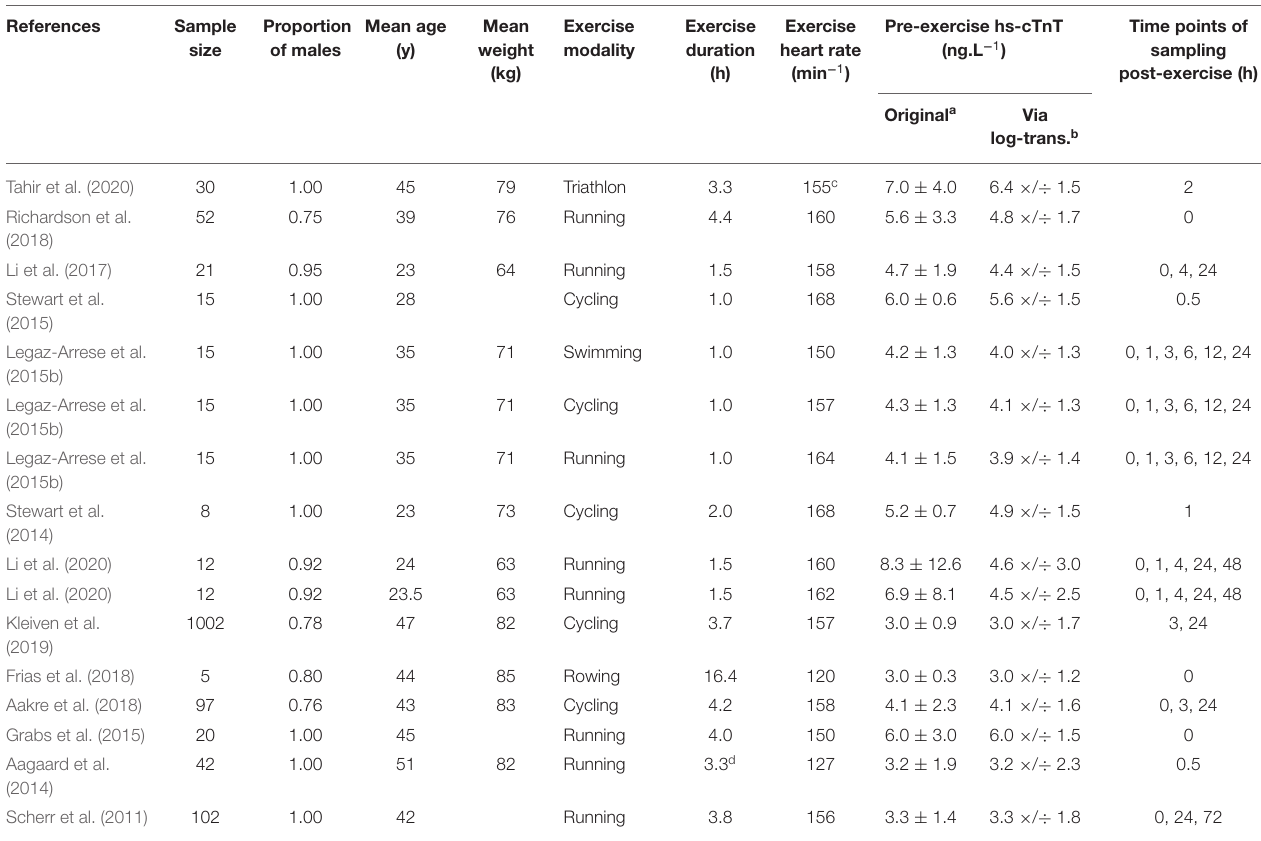
TABLE 1 | Descriptive statistics of studies included in the